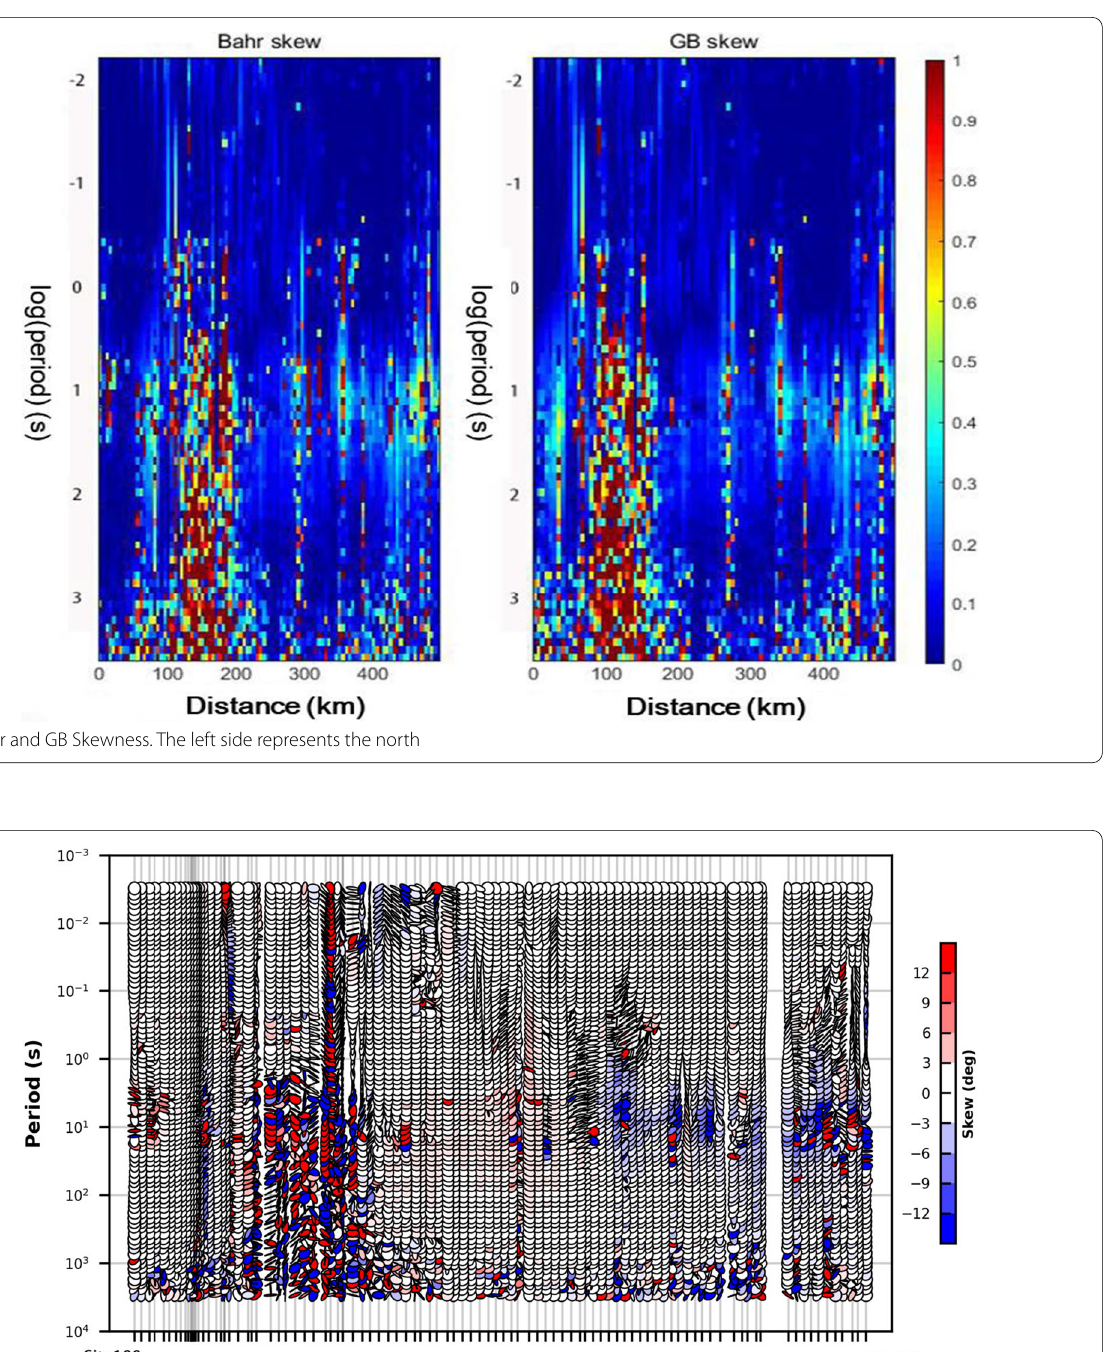
o overall strike direction is about NE 45 . Since the regional tectonic strike is close to the northeast, and the field elec- o ; Fig. 5c tric and magnetic data is collected in north–south, and east–west directions, the original apparent resistivity